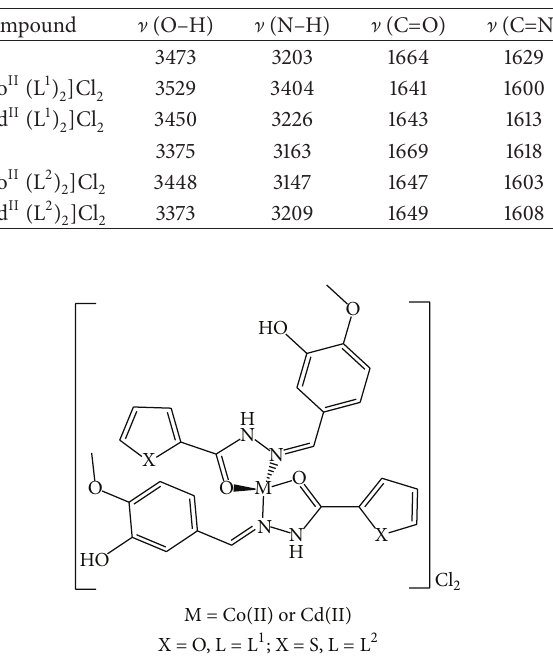
Scheme 1: Synthesis diagram of the Schiff-base ligands (L 1 and L 2 ). Table 2: IR frequencies (cm − 1 ) of the